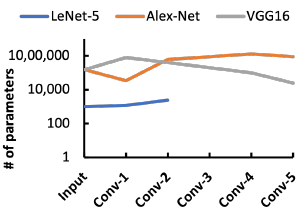
Figure 2. Parameter expansion in different learning